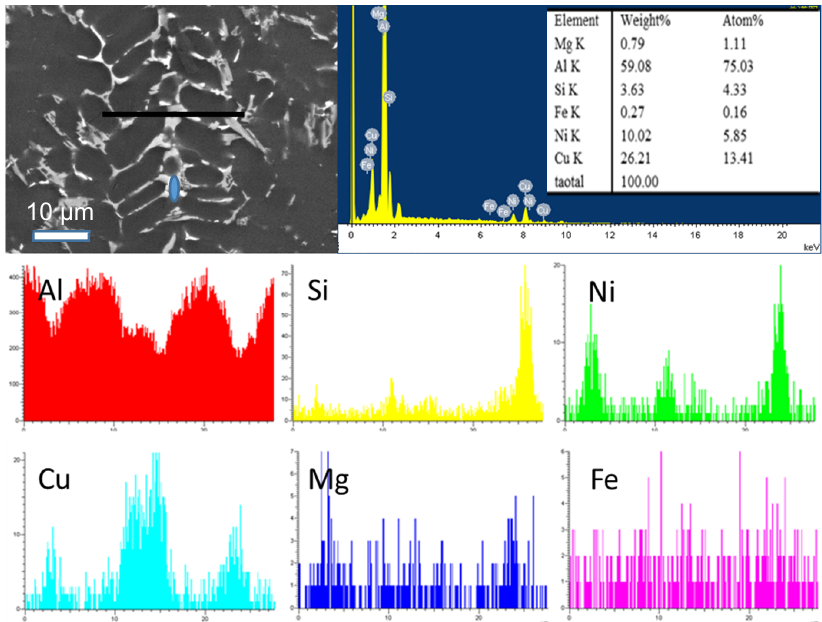
Figure 5 . SEM analysis with the cooling rate of 150 °C/s.